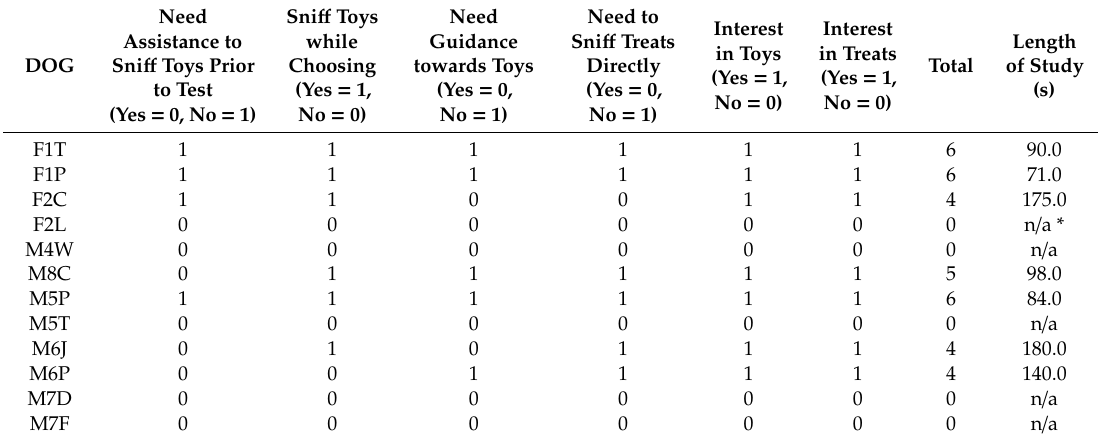
Table 2. The performance evaluation result of the dogs at the end of phase 1.